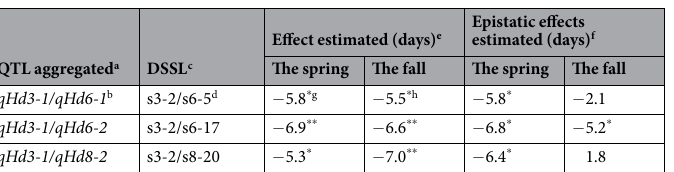
Table S2) were analyzed by QTL.gCIMapping.GUI software. The result indicated that QTL qHd3-1 was precisely determined at 4.4 cM on chromosome 3, being in marker interval of RM3894–RM523 (Fig. 2). Epistatic Interactions between QTLs.